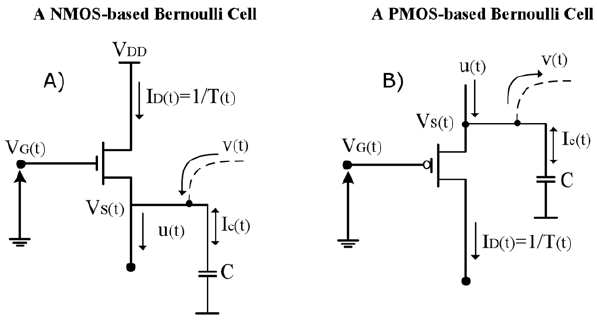
Figure 1. A NMOS and PMOS based Bernoulli Cell. The arrows defining the direction of the capacitor current are bidirectional, since the BC analysis holds, whether the capacitor is connected to ground or V DD .